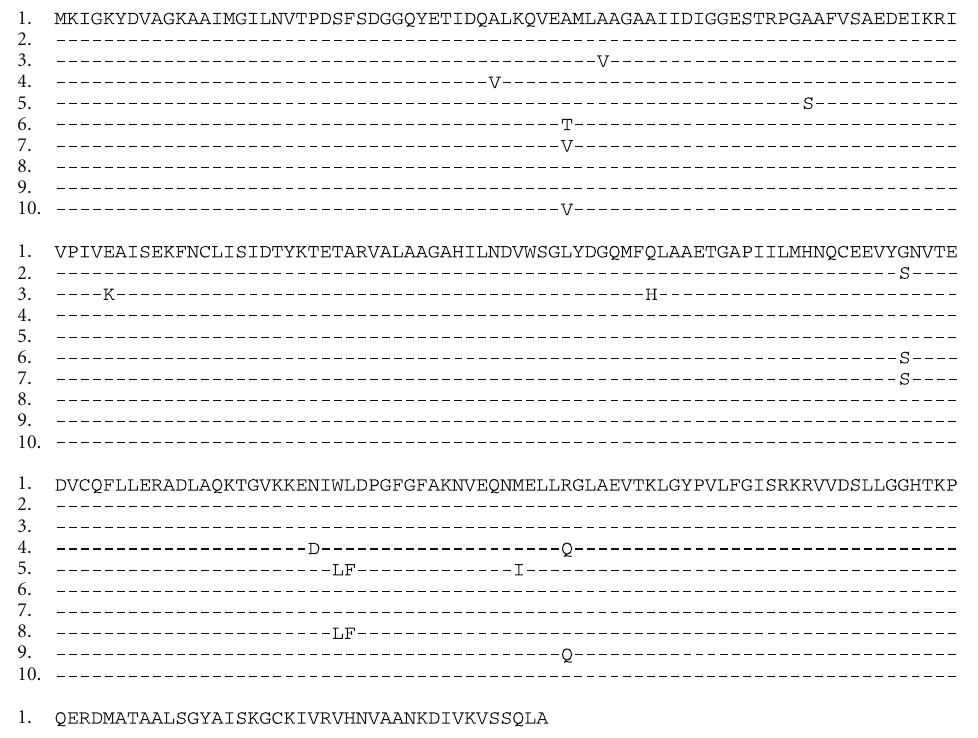
Figure 3: Variations in S. mutans DHPS amino acid